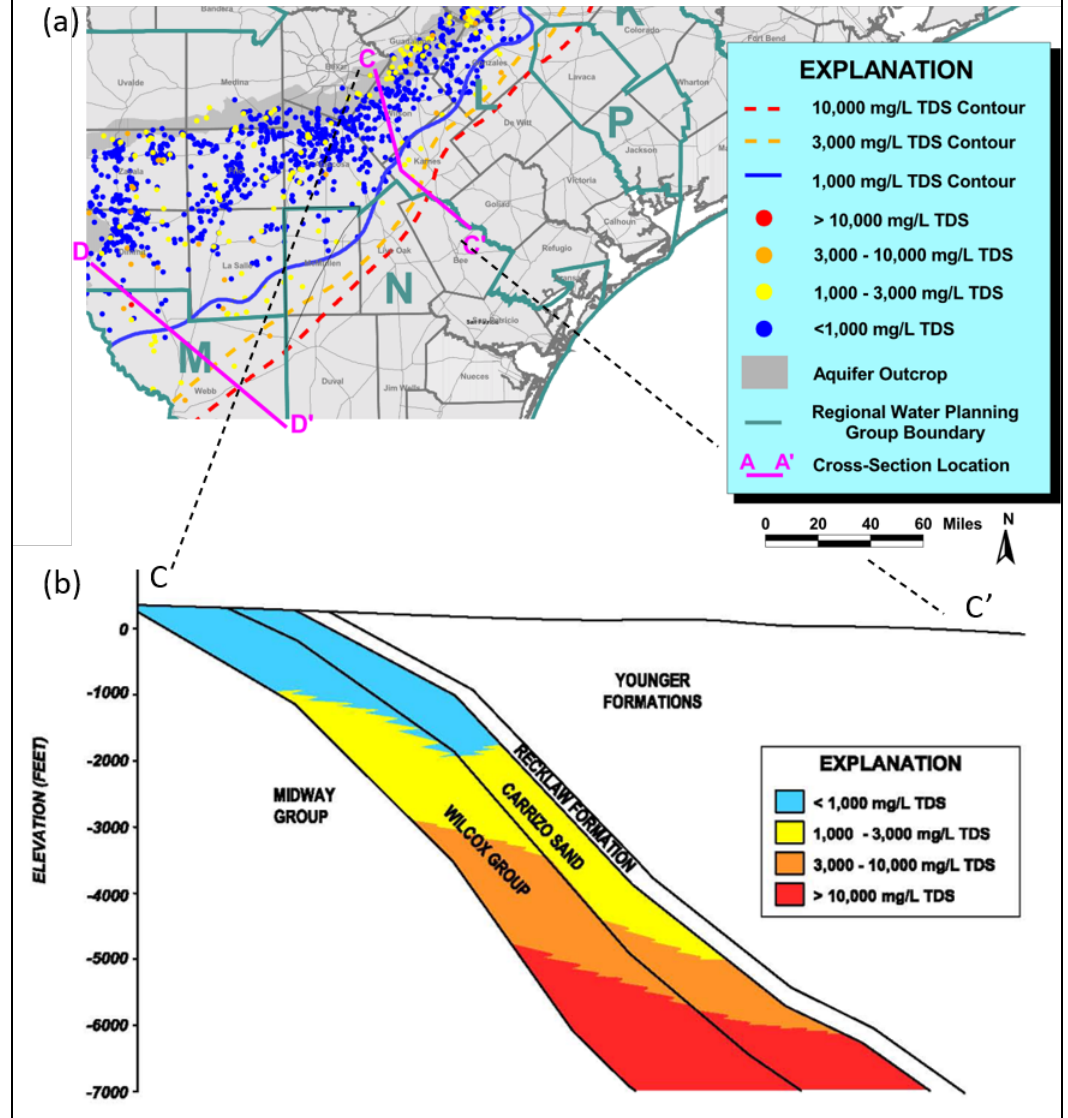
Figure 2. (a) Visual representation of groundwater quality in the Carrizo-Wilcox Aquifer, accompanied by cross section views including formation total dissolved solids (TDS) and depth and (b) simplified cross section C-C’ of the Carrizo-Wilcox Aquifer with generalized water quality ranges (LBG-Guyton Associates